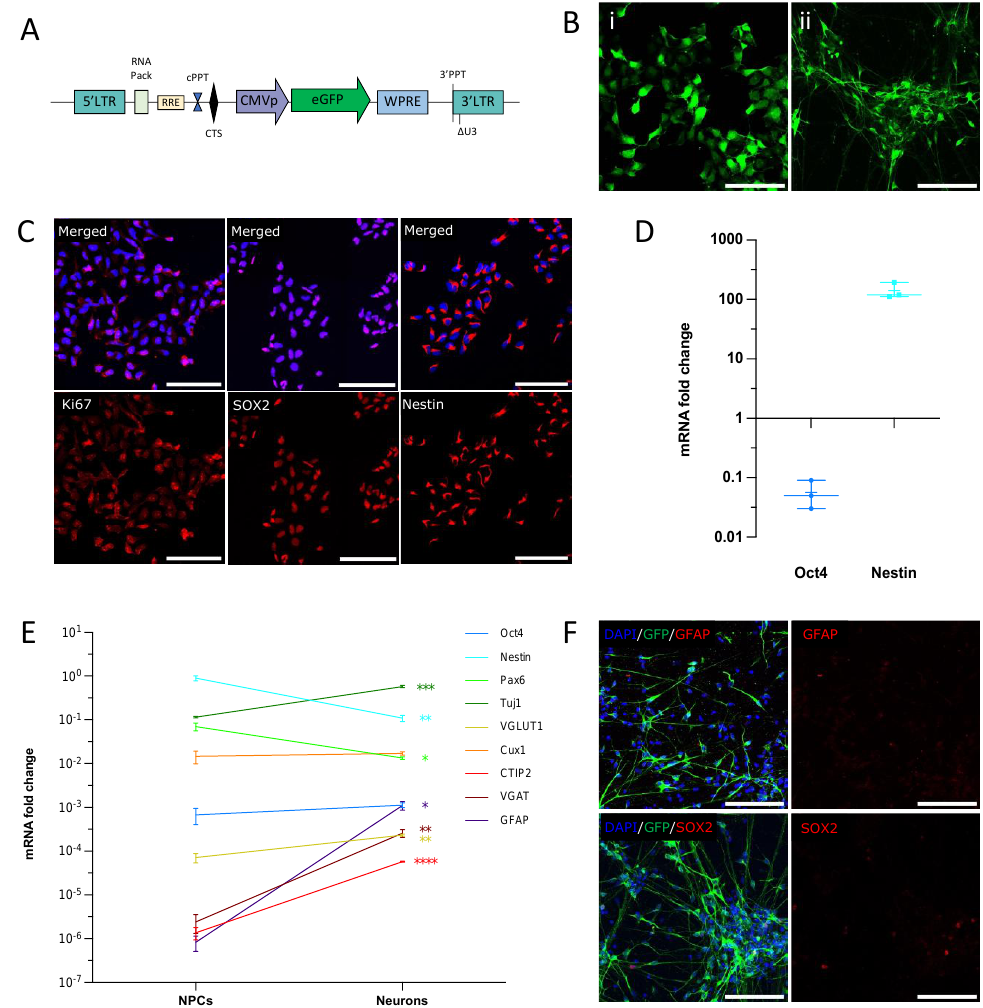
Figure 1. NPCs differentiate into immature cortical neurons in vitro. ( A ) Lentiviral construct expressing GFP used for NPCs labeling, adapted from [9]. ( B ) GFP is expressed in NPCs (left panel) and 30-day-old neurons (right panel). Scale bar = 100 µ m. ( C , D ) NPCs express the neuronal progenitor markers Ki67, SOX2, and Nestin at passage 28 ( C ). The plot ( D ) shows mRNA expression fold-change as compared to human fetal brain. qPCR results were normalized to GAPDH and calculated with the ∆ CT method (data are from three independent cultures). ( E ) mRNA relative expression of differentiation markers at NPCs and neuronal stage. Data are expressed as fold change to GAPDH calculated with the ∆ CT method (* p < 0.05; ** p < 0.002; *** p < 0.0002; **** p < 0.0001, unpaired t -test). ( F ) Neurons do not express the astrocyte marker GFAP. Only a small proportion of cells remained SOX2 positive after 30 days of differentiation. Scale bars = 100 µm.